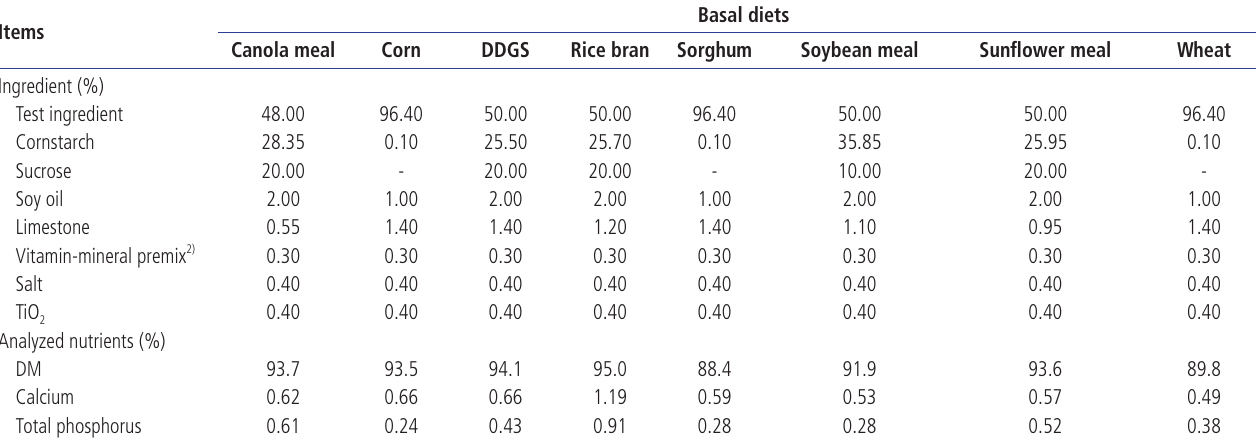
Table 1. Ingredient and analyzed nutrient composition of basal diets (as-fed basis) 1)